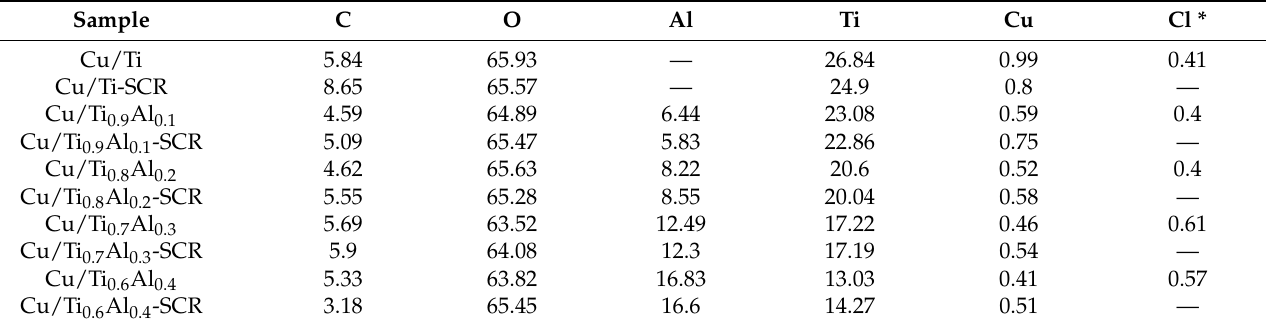
Table 2. Surface elemental composition of fresh and used catalysts (at.%).